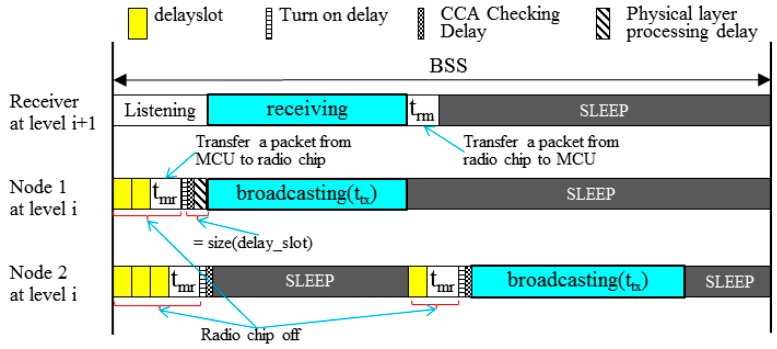
Figure 4. An example of a broadcast process between two neighboring nodes.